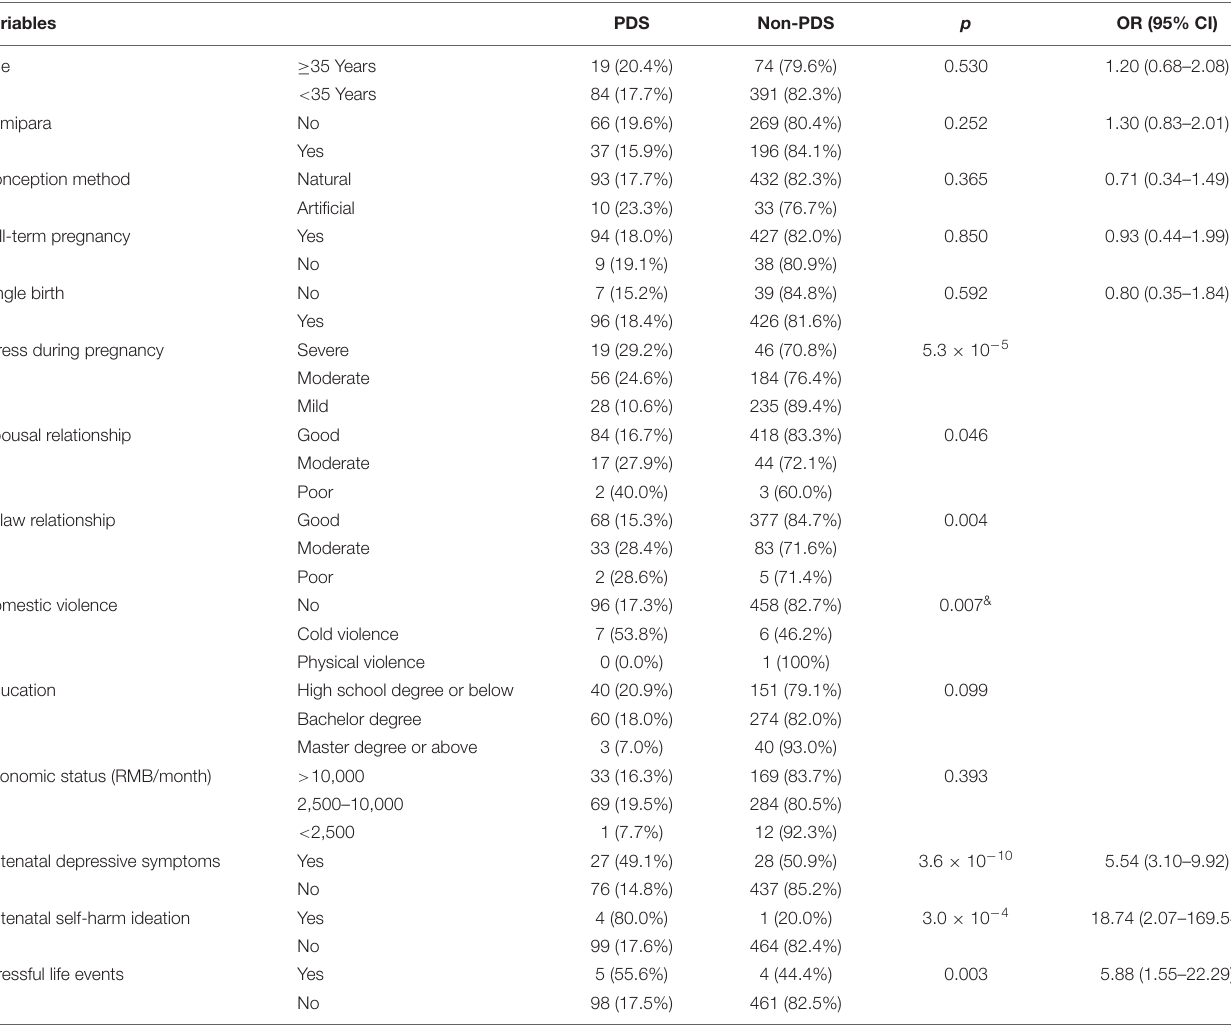
TABLE 1 | Clinical characteristics of all participants.